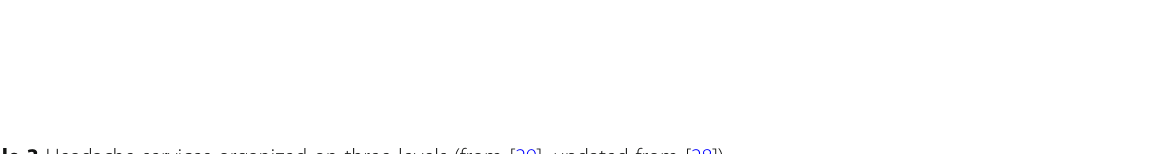
Table 3 Headache services organized on three levels (from [29], updated from [28]) Level 1. General primary